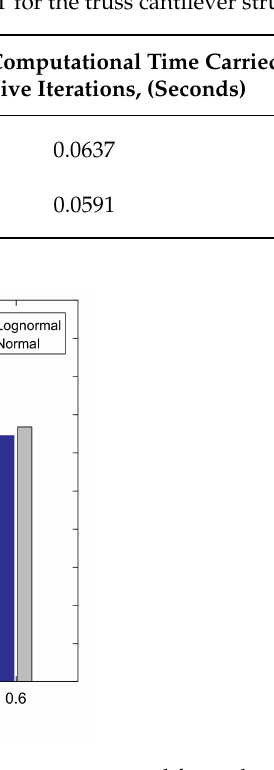
Figure 11. Optimal volumes versus correlation between external forces having different marginal